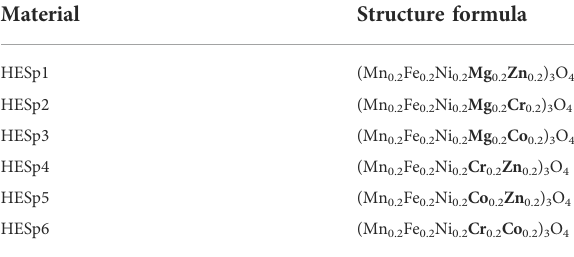
TABLE 1 Overview of the high-entropy spinel (HESp) materials. Material Structure formula